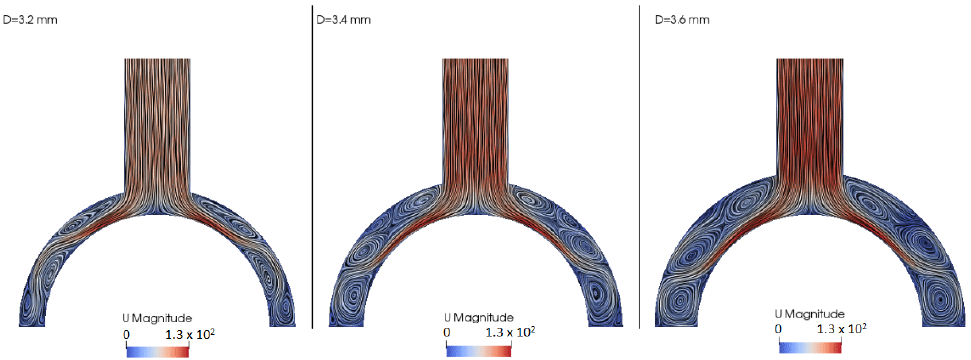
Figure 10. Vortical structures and velocity contours at plane ( z = z 2 ) for different gripper body diameter values ( D ) ( d = 0.77 mm, L = 32.2 mm, p 2 = 90 kPa).